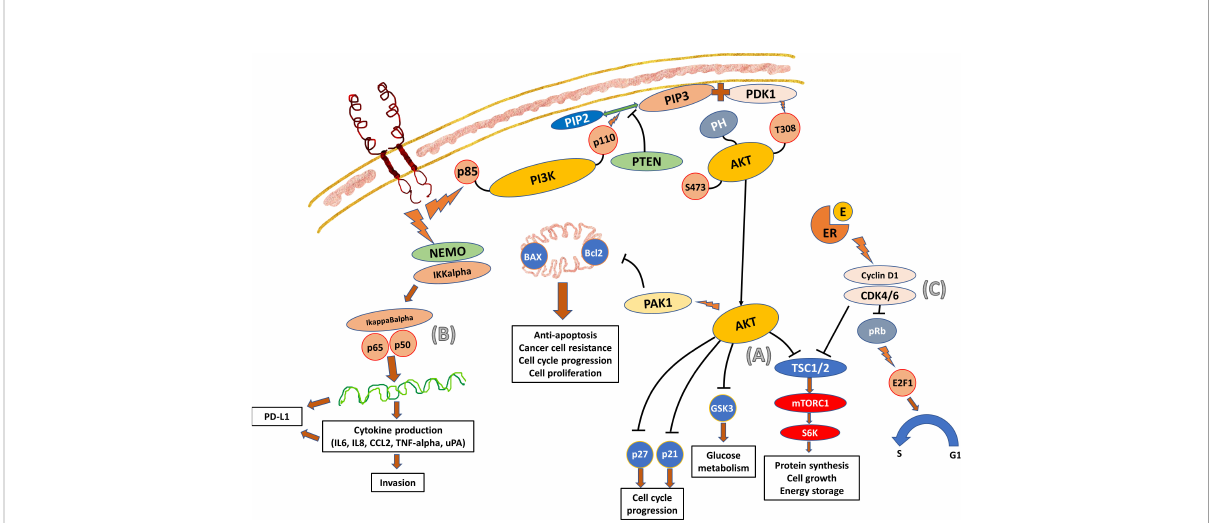
FIGURE 1 Crosstalk Between the PI3K/AKT, NF-kappaB, and Cyclin D1-CDK4/6-pRb Pathways. (A) PI3K is a heterodimeric protein consisting of regulatory (p85) and catalytic (p110) components. The p85 regulatory subunit contains two SH2 groups. PI3K interacts with Ptdlns (3 – 5) P3 (PIP3) and the effector AKT. The activated TKD of HER2 receptor recruits PI3K towards the cell membrane and activates the p85 regulatory components (7). The p110 catalytic component then in turn phosphorylates the PIP3 membrane phospholipid which recruits the plekstrin homology (PH) domain of the AKT protein. The activated PIP3 also binds to 3-phosphoinositol-dependent protein kinase-1 (PDK1) allowing it to access and phosphorylate the Thr308 catalytic unit of AKT. The activated AKT then moves to the cell to activate a number of cellular processes stimulating cell growth and inhibiting cell apoptosis. One of the main roles is to phosphorylate and inhibit tuberous sclerosis complex (TSC) subunits 1 and 2 (TSC1/2) and activate mTOR complex 1 (mTORC1), which in turn activates ribosomal protein S6 kinase (S6K) and ribosomal S6 to promote protein synthesis and cell growth (8). (B) NF-kappaB can be activated by the classical canonical cascade starting from the cell surface receptor and by the alternative non-canonical cascade. The signal from the activated TKD of HER2 receptor is transferred into the cytoplasm and activates NF-kappaB by the classical canonical pathway (9). The activation involves IKKalpha and IKKbeta catalytic subunits of the IkappaB kinase (IKK) complex which degrades the IkappaB inhibitory protein of NF-kappaB. As a result, the released NF-kappaB dimers translocate to the nucleus and activate the downstream gene transcription, producing cytokines (IL-6, TNF-alpha, IL-4 and IL-5), chemokines (IL-8, RANTES, MIP- 1alpha, MCP-1), adhesion molecules, and other enzymes that lead to the in fl ux of T-cells, B-cells, monocytes, dendritic cells, and NK-cells into the tumor. The dynamics of these tumor in fi ltrating lymphocytes (TIL) will determine the aggressiveness and invasiveness of the cancer. It is well documented that cancers with higher percentage of TIL have a better response to treatment and survival outcome. (C) CDK4/6 interacts with cyclin D1 and inactivates the retinoblastoma (Rb) tumor suppressor protein (pRb) to promote the transcription factor E2F1 to control cell cycle transition from G1 to S phase (10). The cyclinD1-CDK4/6 complex is also responsible for the phosphorylation of TSC 1 and 2, which in turn leads to the phosphorylation of S6K and mTORC1, one of the downstream signal cascades of